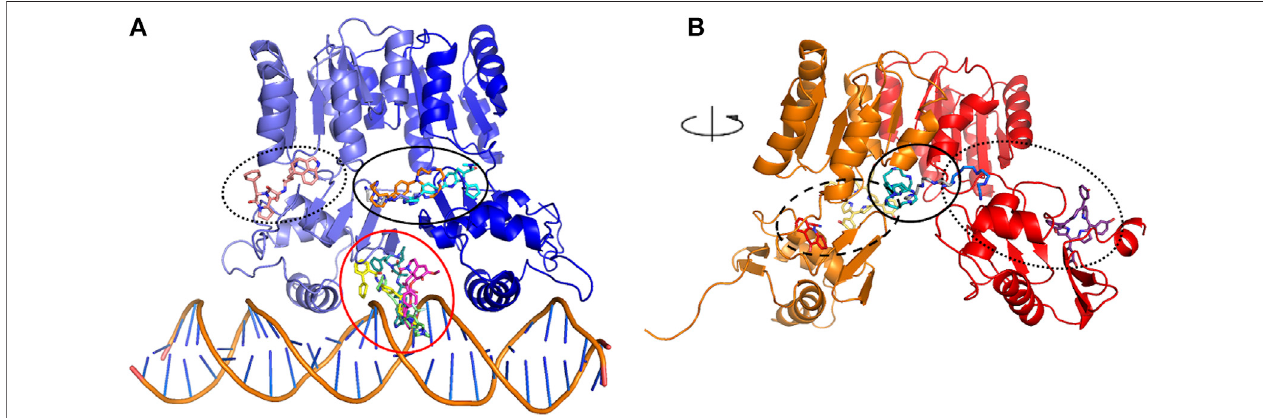
FIGURE 2 | Docking binding sites for HP1043 – DNA (A) and HP1043 (B) . Main binding sites are evidenced in circles, interface between the dimerization and the DNA-bindingdomains, and/or betweenthetwoHP1043 chainsinsolidline,Achainindashed line,Bchainondottedline,and interfacebetweenprotein andDNAinred